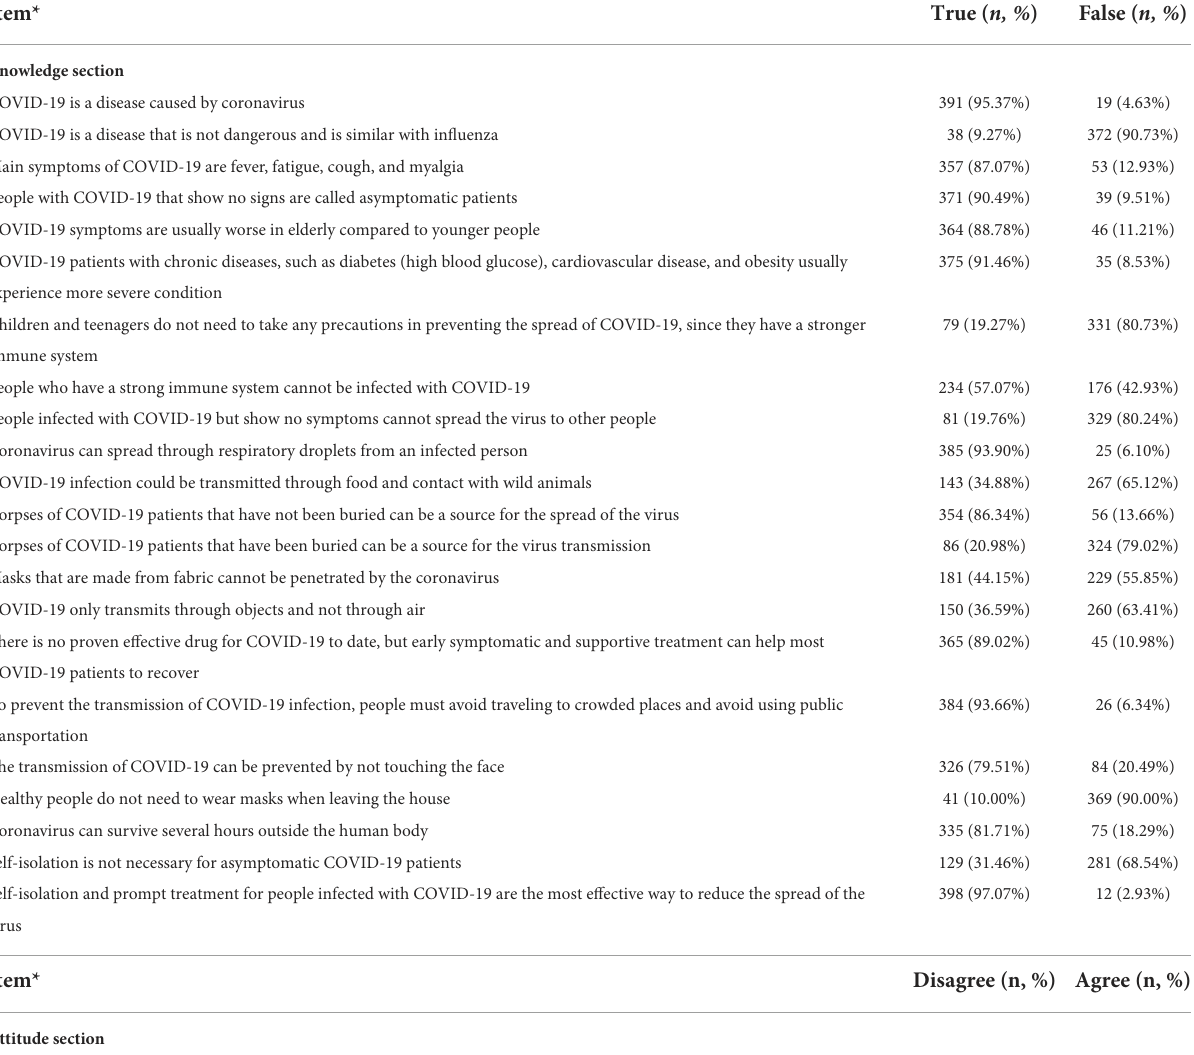
TABLE 1 Frequencies and percentages of every response in each item in knowledge and attitude